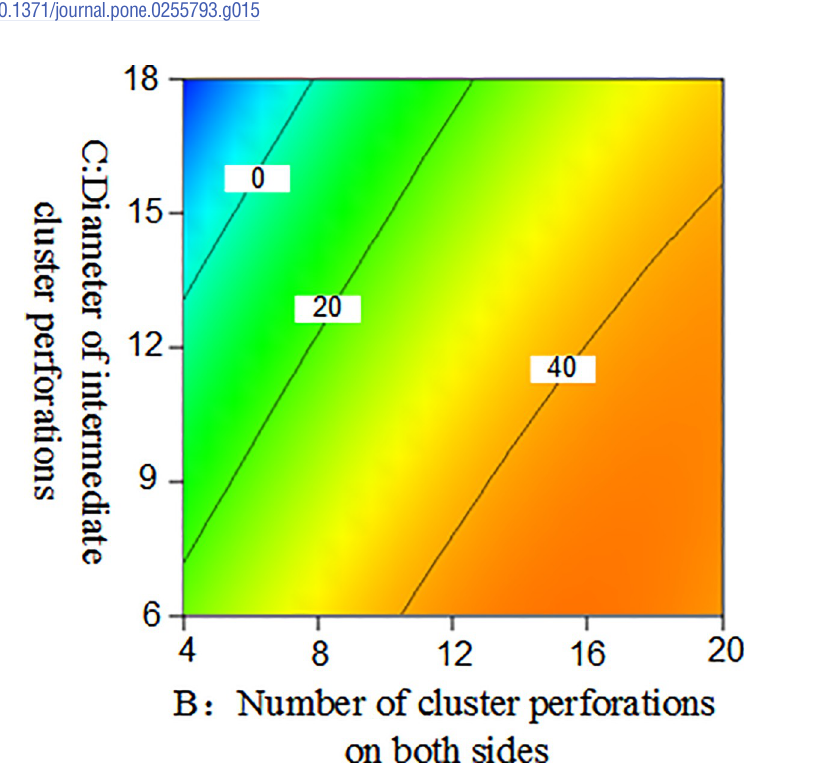
Fig 16. Two-dimensional contour map of the number of cluster perforations on both sides and the diameter of the middle cluster perforation hole on the seam length difference.